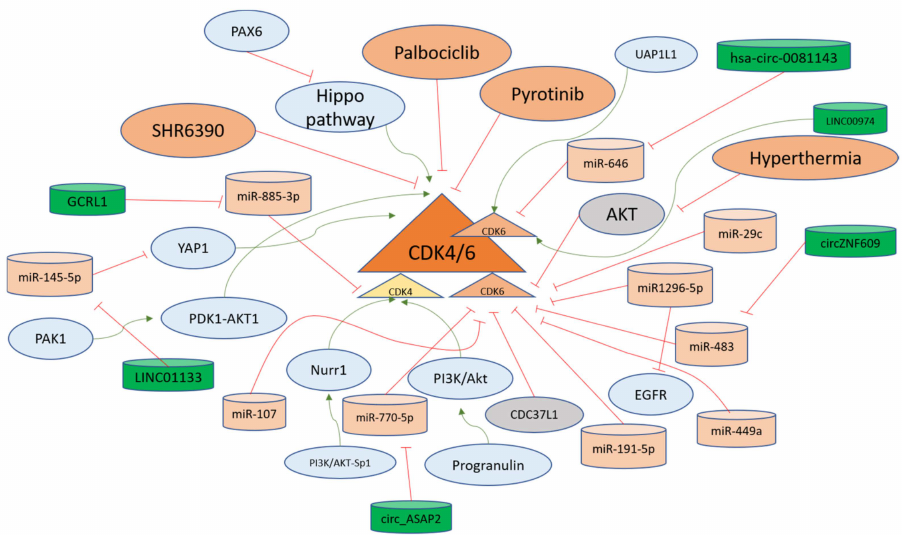
Figure 4. CDK4/6 regulation in gastric cancer progression. CDK4/6 are kinases that accelerate the cell cycle progression from the G1 phase. Different long non-coding RNAs (green) facilitate the upregulation of these CDKs via sponging (red lines) microRNAs (orange). Moreover, other pathways such as PI3K-Akt and Hippo function in activating (green arrows) the CDK4/6 for developing gastric cancer. The negative upstream regulators of CDK4/6, such as CDC37L1 and AKT, are shown in grey and keep the levels of CDK4/6 down in gastric cells. The overall mechanisms for the regulation of CDK4/6 in the gastric cells are explained in the main text.